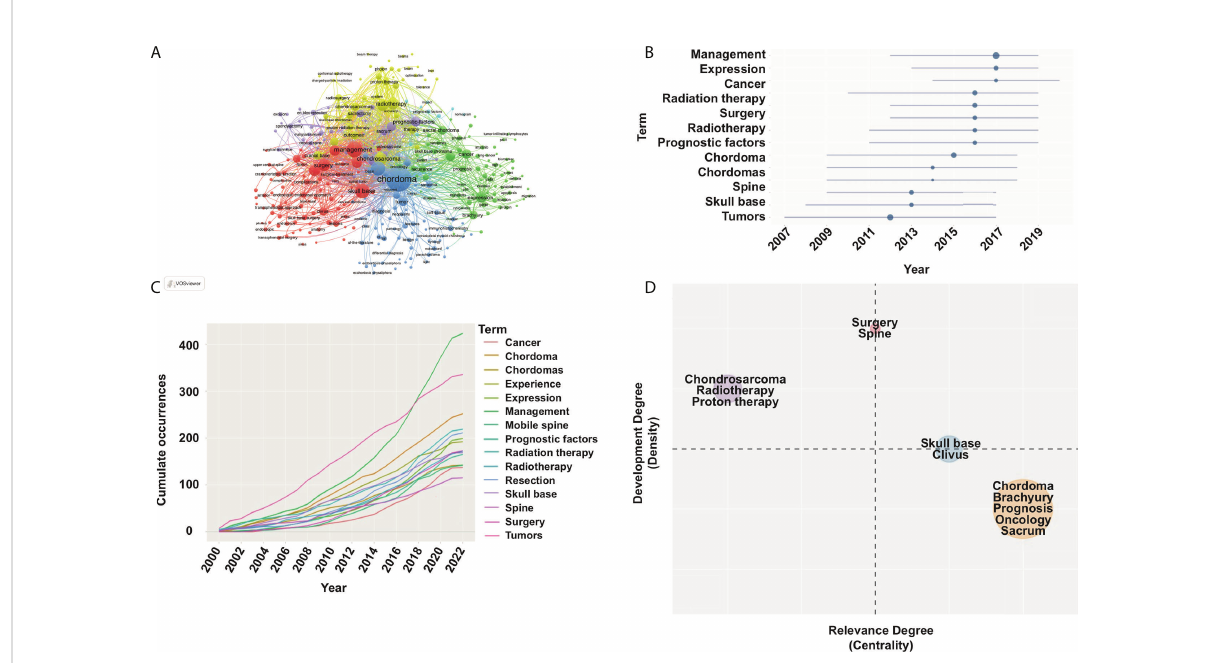
FIGURE 5 Keyword co-occurrence map with an occurrence frequency of more than 5 based on VOSviewer and Blibliometrix. (A) Network visualization; (B) topic trend of high-frequency keyword in chordoma fi led; (C) high-frequency keyword dynamics; (D) strategic diagram in chordoma